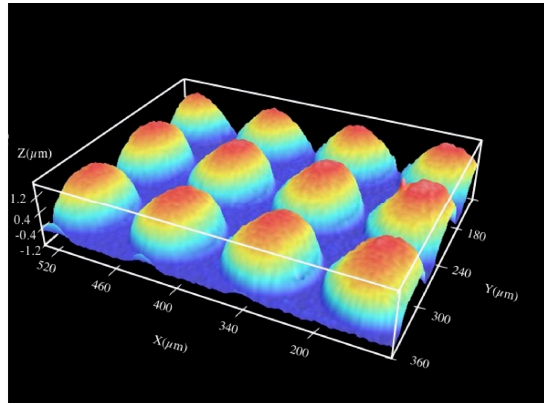
Figure 1. Confocal image of the microlens array with period of 90 μ m.